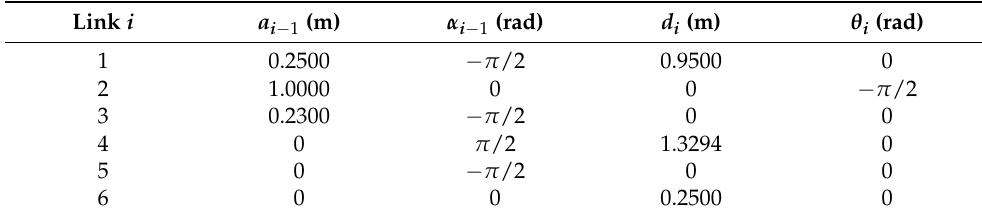
Table 1. DH-kinematic parameters. Link